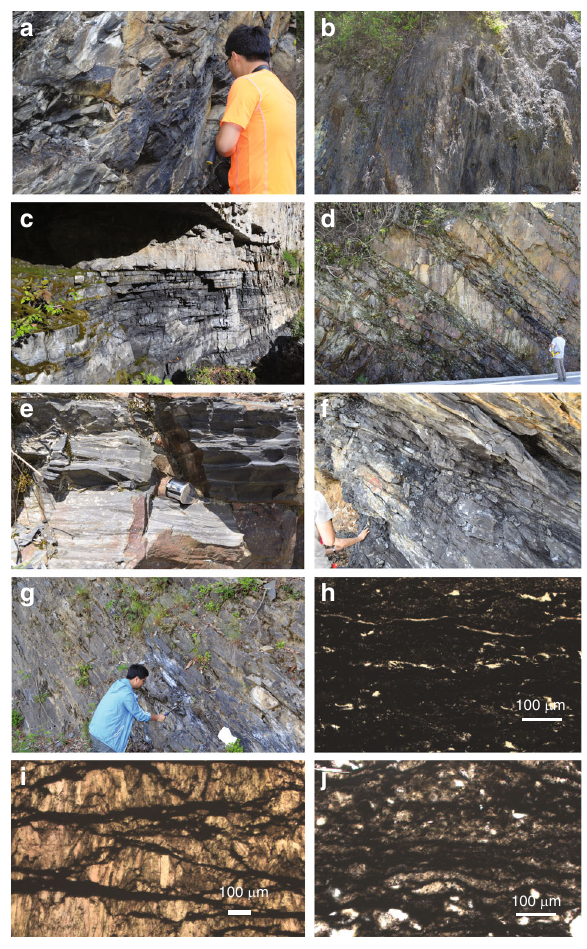
Fig. 2 Outcrop photos and thin section photomicrographs of selected samples. a Outcrop photo of black shales from the Zhangjiaya Formation, b outcrop photo of shales from the Wenshuihe Formation, c alternating black shales and carbonates from the upper Taizi Formation, d alternating sandstones and black shales from lower in the upper Taizi Formantion than in photo, d , e close-up of sandstone unit from the upper Taizi Formation showing cross laminations that we interpret as evidence for a mass fl ow deposit, f a layer of massive black shale from the lower Taizi Formation, g shales from the Dayanping Formation, h thin section photomicrograph of black shale from the Zhengjiaya Formation (sample SZY-5), i thin section photomicrograph of organic matter layered carbonate-rich sediment from the upper Taizi Formation (sample TZ-1-3), j thin section photomicrograph of black shale from the lower Taizi Formation (sample TZ-26). Scale